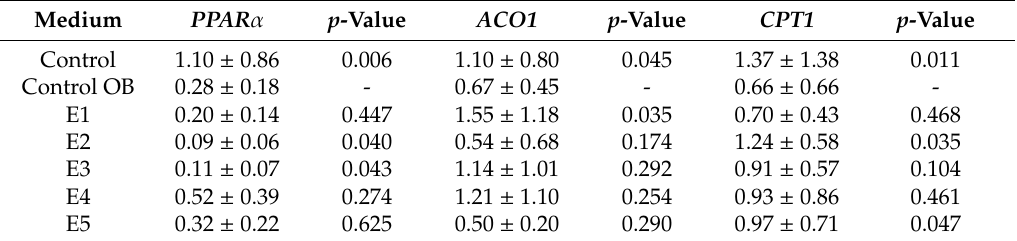
Table 1. Relative expression of lipolytic genes compared to the control.